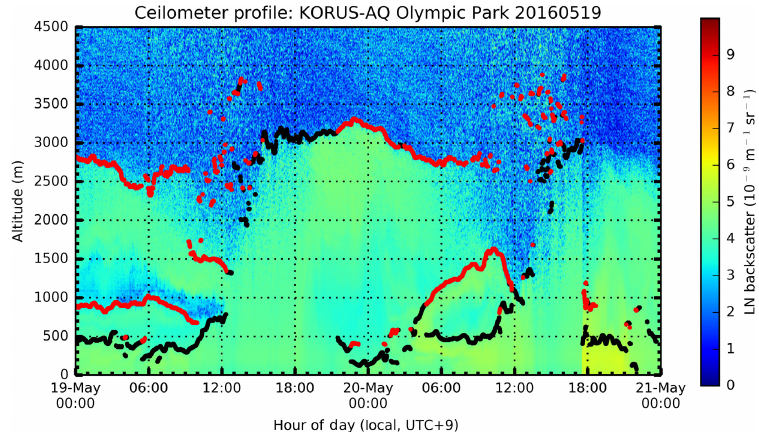
Figure 9. Vaisala Ceilometer CL51 backscatter measurements (910nm) on 19 and 20 May 2016 at Olympic Park, during KORUS-AQ. Black dots represent MLH used in this study.